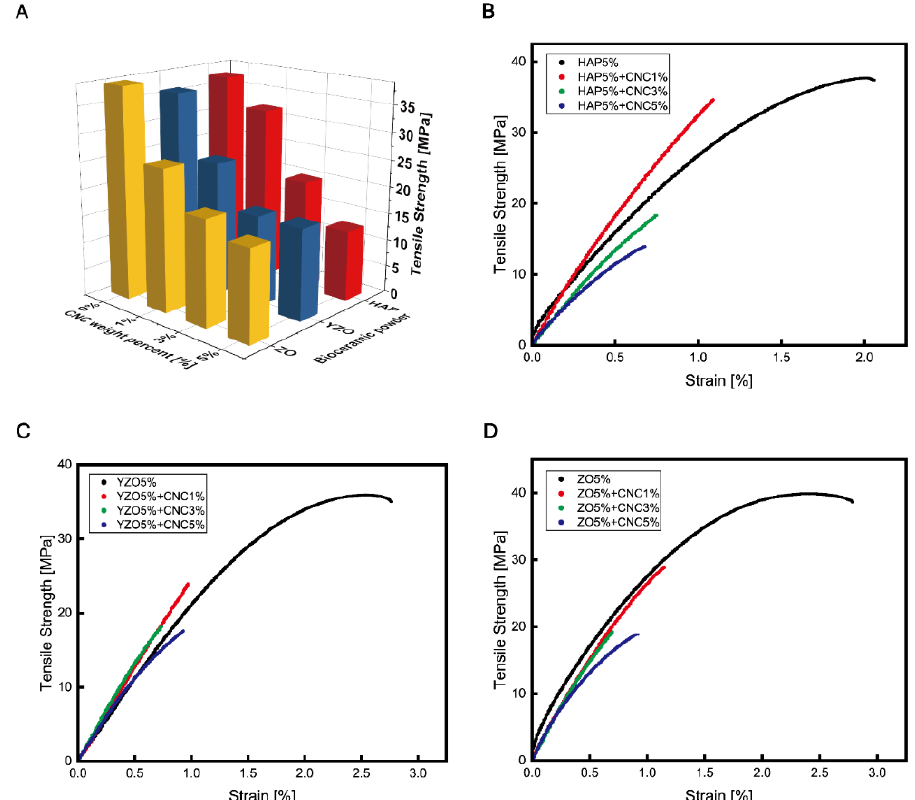
Figure 6. ( A ) Comparison of tensile strength change according to CNC weight percentage in each bioceramic–epoxy composite material. ( B ) Tensile strength vs. strain in HAP–epoxy composite material as a function of CNC content. ( C ) Tensile strength vs. strain in YZO–epoxy composite material as a function of CNC content. ( D ) Tensile strength vs. strain in ZO–epoxy composite material as a function of CNC content.